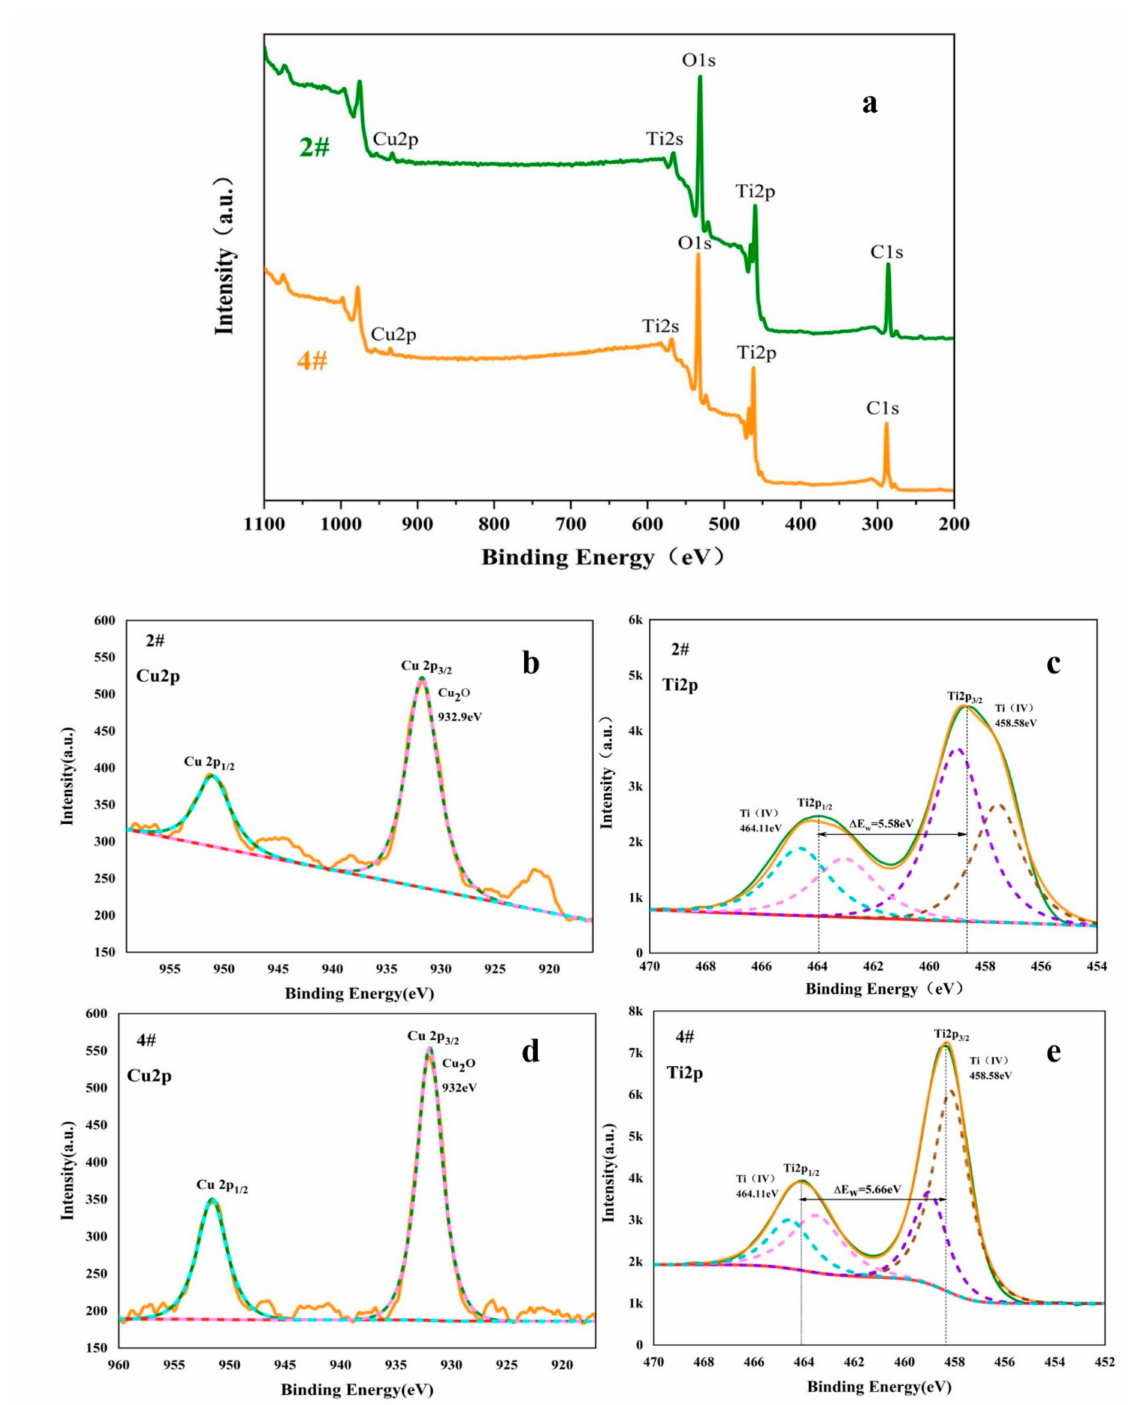
Figure 2. XPS spectra of 2# and 4# samples: ( a ) full spectrum, ( b ) 2# Cu2p, ( c ) 2# Ti2p, ( d ) 4# Cu2p, ( e ) 4#